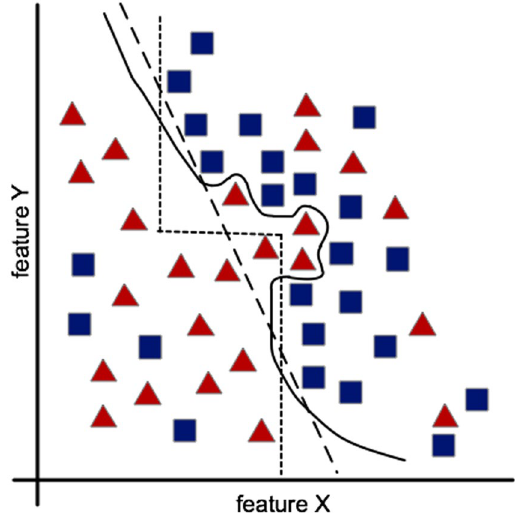
Figure 1. DT classification boundaries. Example of univariate (dotted line, three rules), linear multivariate (dashed line, one rule) and nonlinear multivariate (solid line, one model)